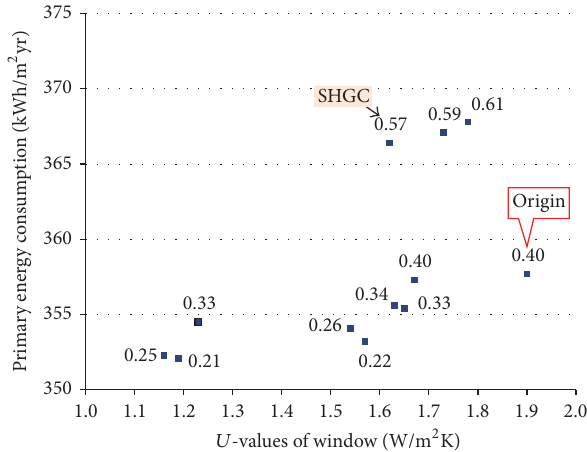
Figure 2: Primary energy consumption according to the window performance of the target building.